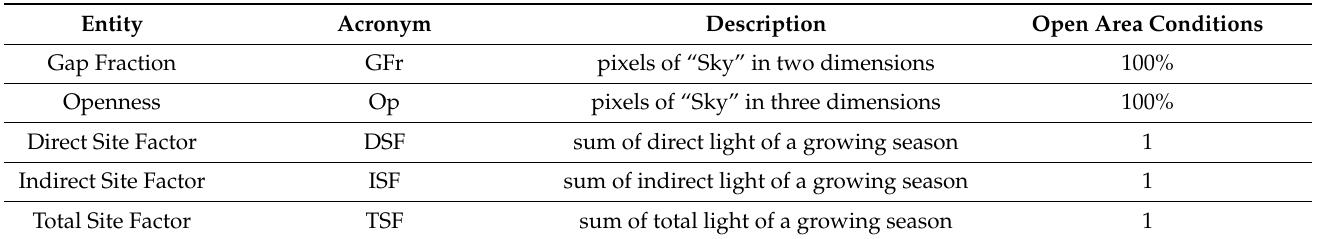
Table 3. Characteristics of light intensities and canopy openness based on hemispherical photography evaluation used in this